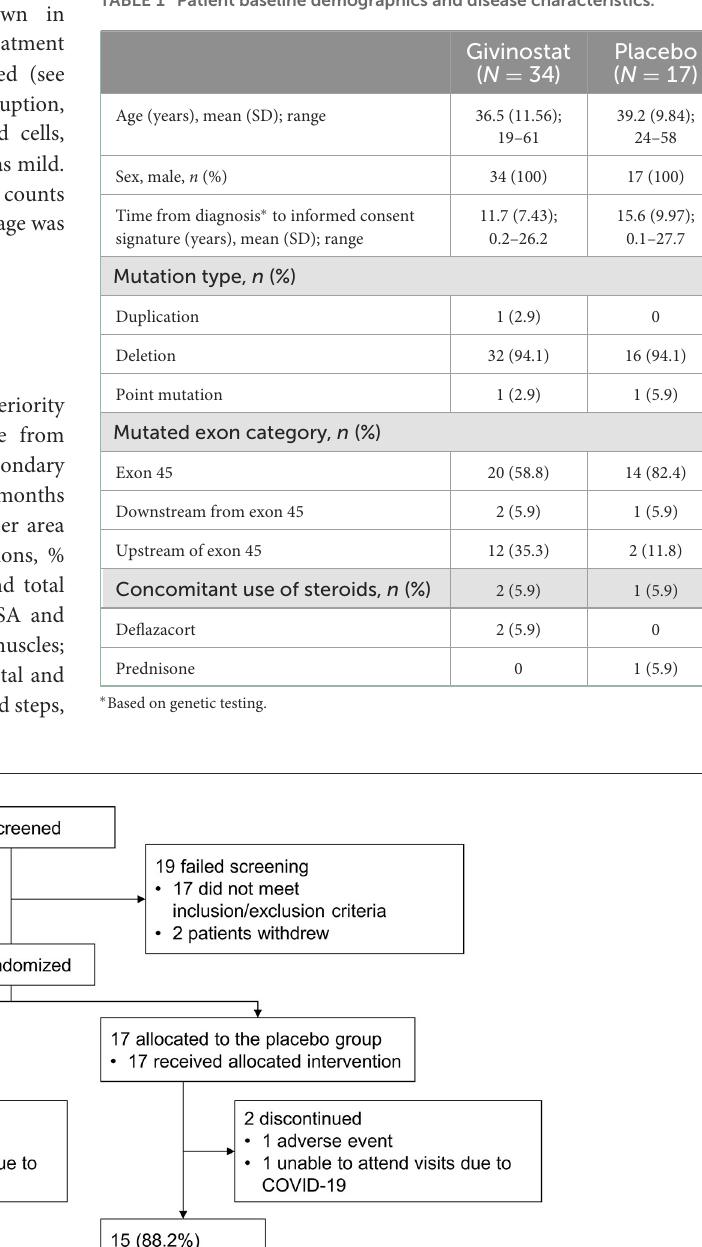
TABLE 1 Patient baseline demographics and disease characteristics.